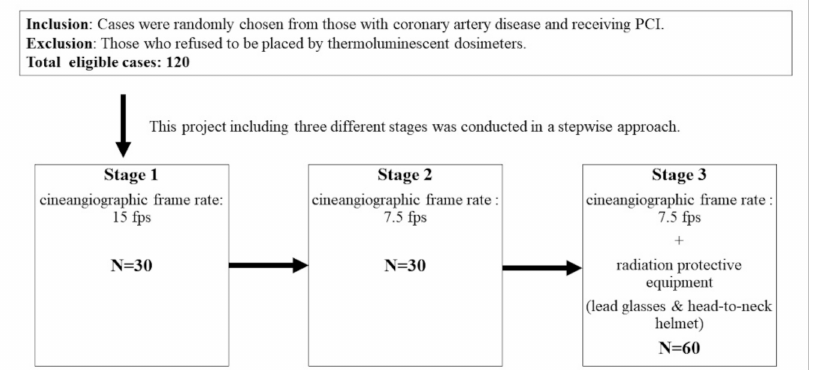
Figure 1. The study flow-chart. This study included patients who were admitted for PCI. Those who refused to be placed on thermoluminescent dosimeters were excluded. After coronary angiography, those for whom PCI was not recommended would be excluded from this